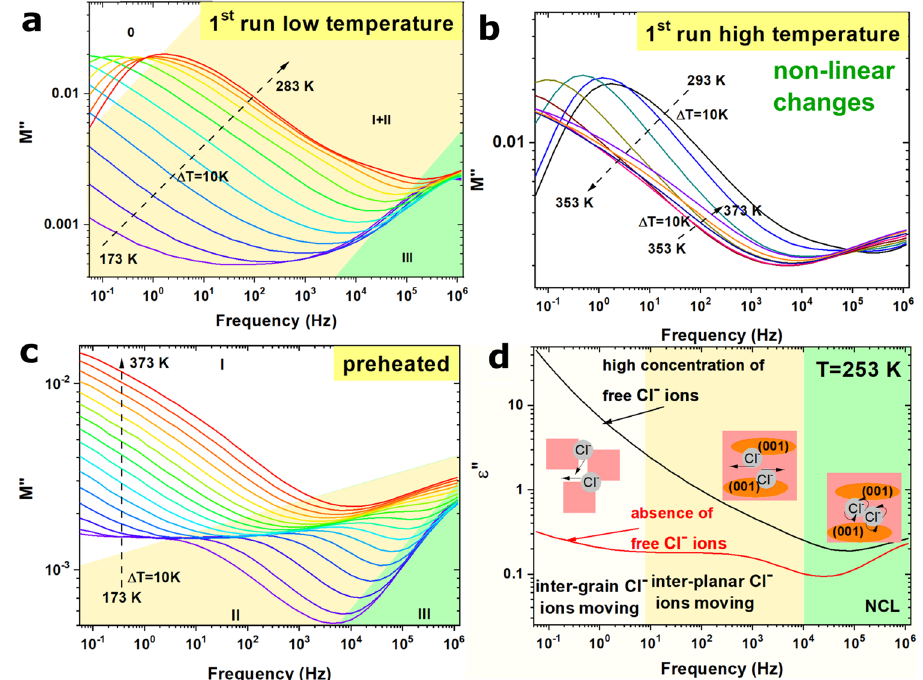
Figure 4. ( a ) Imaginary part of electric modulus M ″ for BiOCl before heating at 283 K with marked characteristic regions; ( b ) imaginary part of electric modulus M ″ for BiOCl before heating at high temperatures 293–373 K; ( c ) imaginary part of electric modulus M ″ for preheated BiOCl over a wide temperature range to 373 K with marked characteristic regions; ( d ) ε ″ spectra for BiOCl before (black line) and after heating (red line) with marked regions corresponding to the regions marked in the M ″